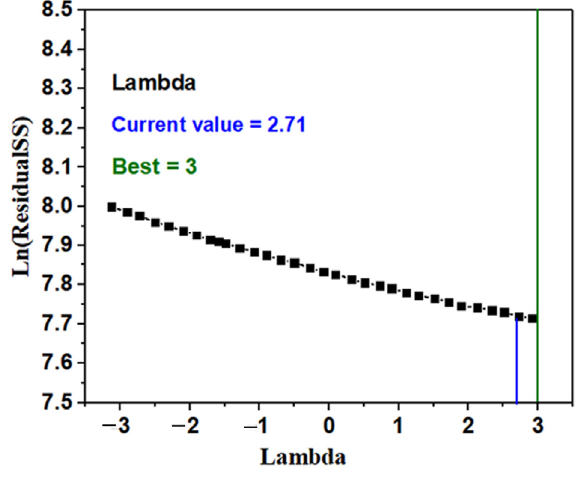
Figure 5. Box–Cox plot for power transformation.